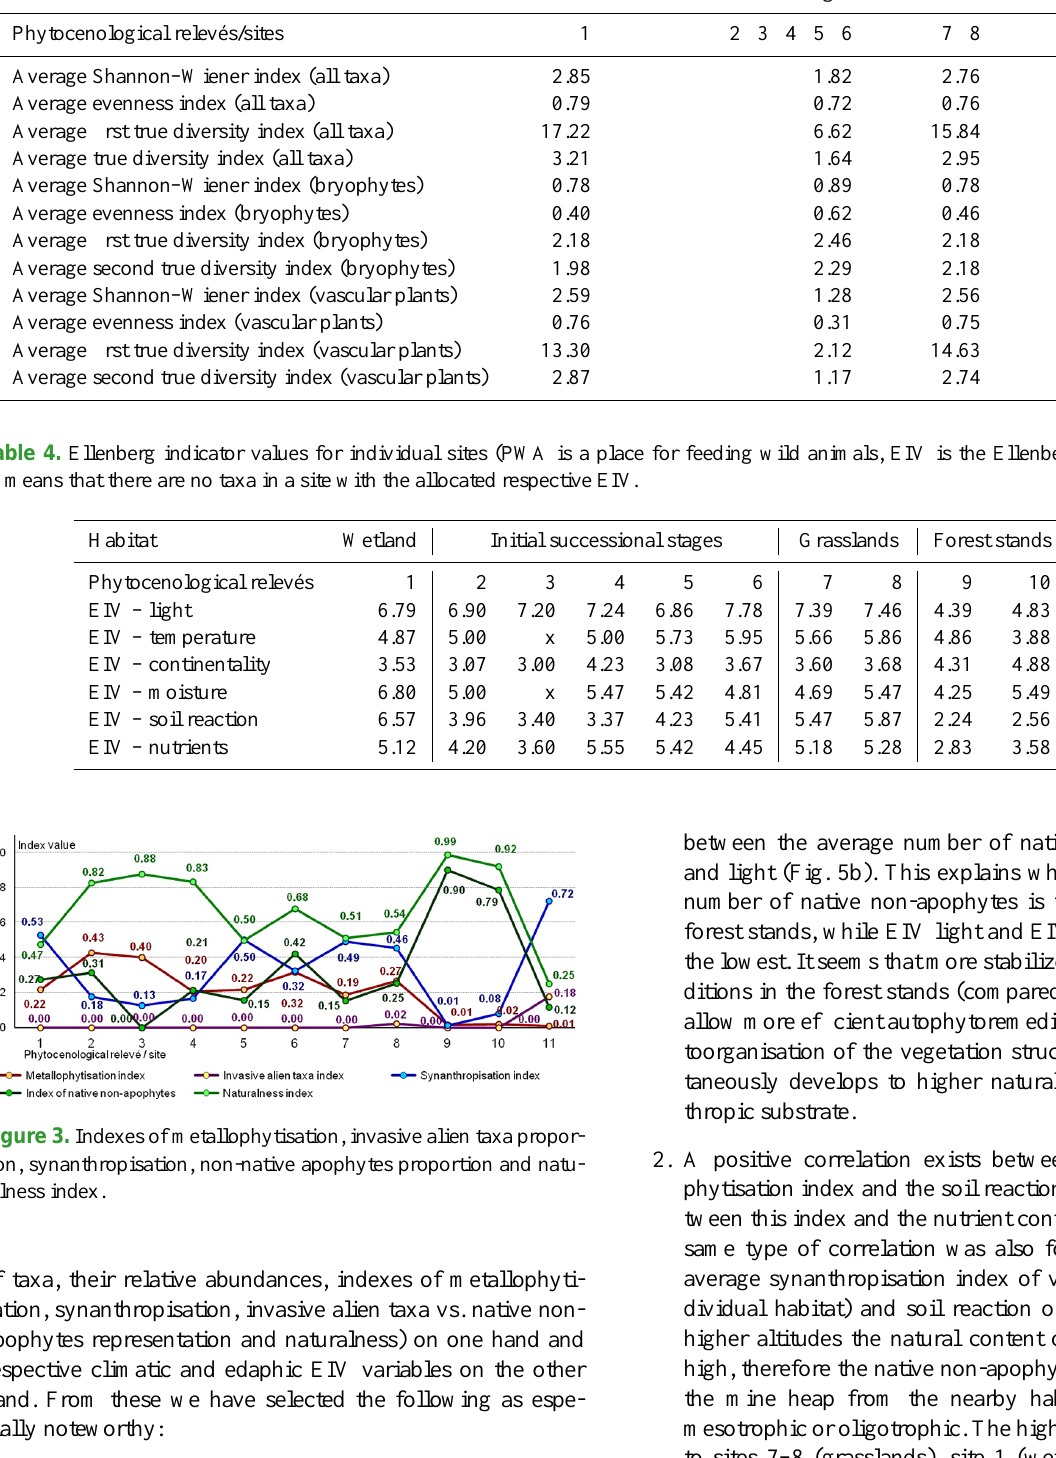
Table 3. Average diversity indexes of vegetation per individual habitats and calculated separately for the total taxa determined in the sites, bryophytes and vascular plants. (PWA is a place for feeding wild animals). Habitats Wetland Initial successional stages Grasslands Forest stands PWA